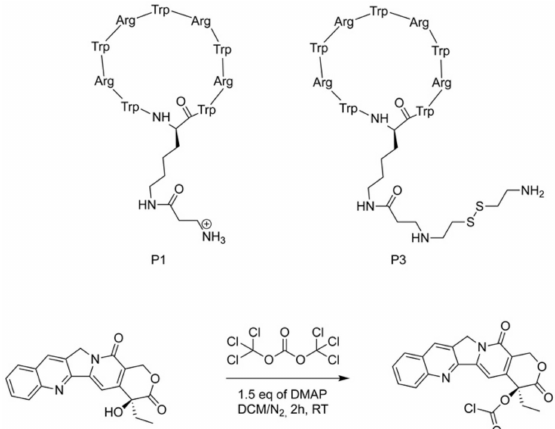
Figure 3. Chemical structure of the cyclic CPP P1 and P3 (after linker introduction). Chemical modification of the drug camptothecin (CPT) before its coupling, according to reference